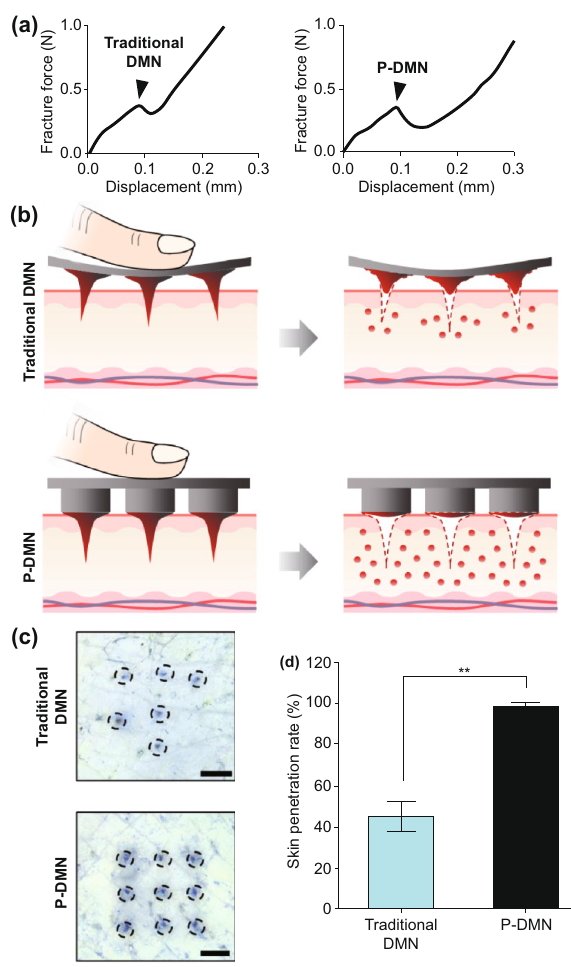
Fig. 14 Evaluation of mechanical force and insertion of traditional MNs and pillar-integrated microneedles (P-DMNs). a The mechani- cal fracture force of DMNs proved their ability to puncture the skin without breakage. b Illustration of DMN application onto the skin. The uniform distribution of the application force in P-DMNs leads to complete delivery of the encapsulated drugs. c Traditional DMNs exhibited an incomplete array of spots, while a uniform pattern of 3 × 3 spots was achieved in P-DMN-treated skin. d Assessment of skin penetration. Reprinted from Ref. [192] with permission from